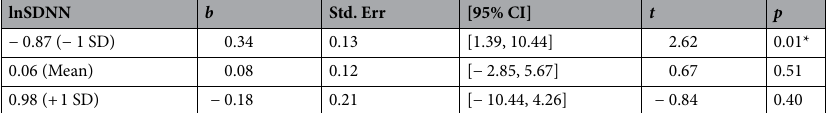
Table 4. Results of the simple slopes analysis on the moderating effect of HRV (lnSDNN) in the prediction of PTSS (IES-R) from expressive suppression (ERQ-S) scores. lnSDNN natural logarithm of standard deviations of N–N intervals, SD standard deviation, CI confidence intervals. *p < 0.05.